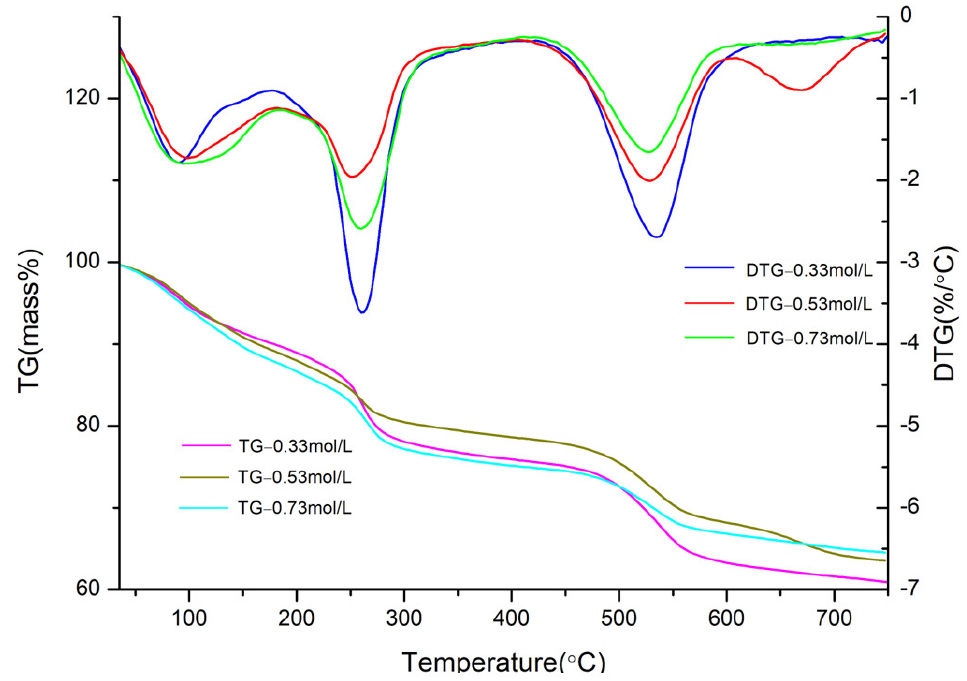
Figure 13. TG-DTG image of CaAl–SiO 3 –LDHs samples prepared at different Ca 2+ molar